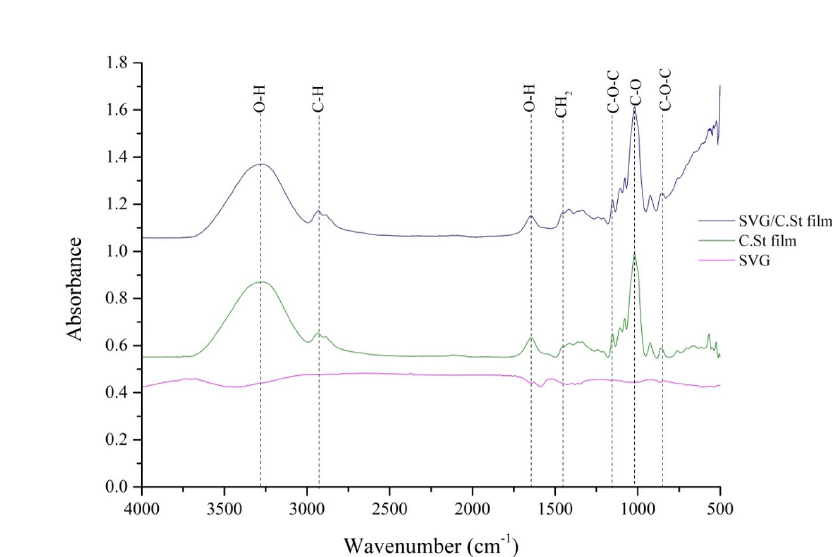
Figure 1: FTIR spectra of silver vein graphite composite (SVG), C.St film and SVG/C.St film.